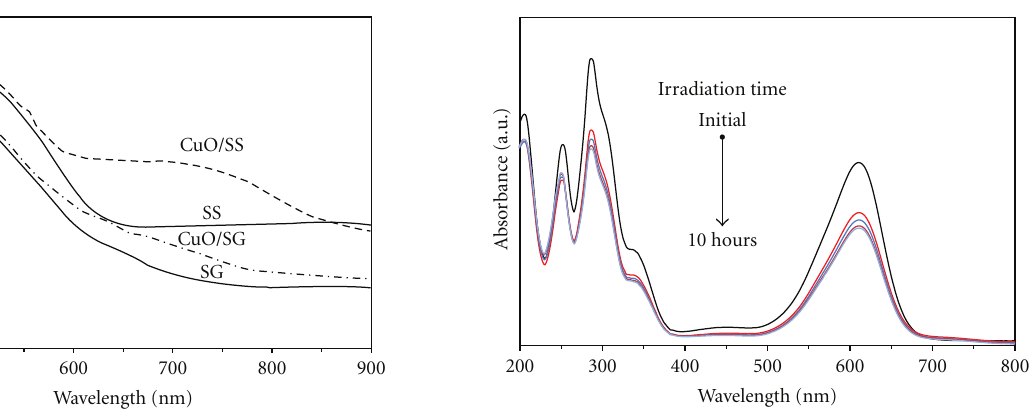
Figure 3: UV-vis spectra of Sm 2 FeTaO 7 materials.